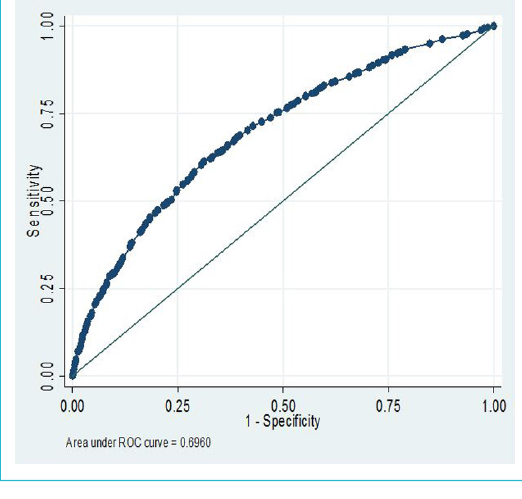
Figure 3: Area under the receiver operating characteristic (ROC) curve of the risk prediction model for potentially avoidable read-